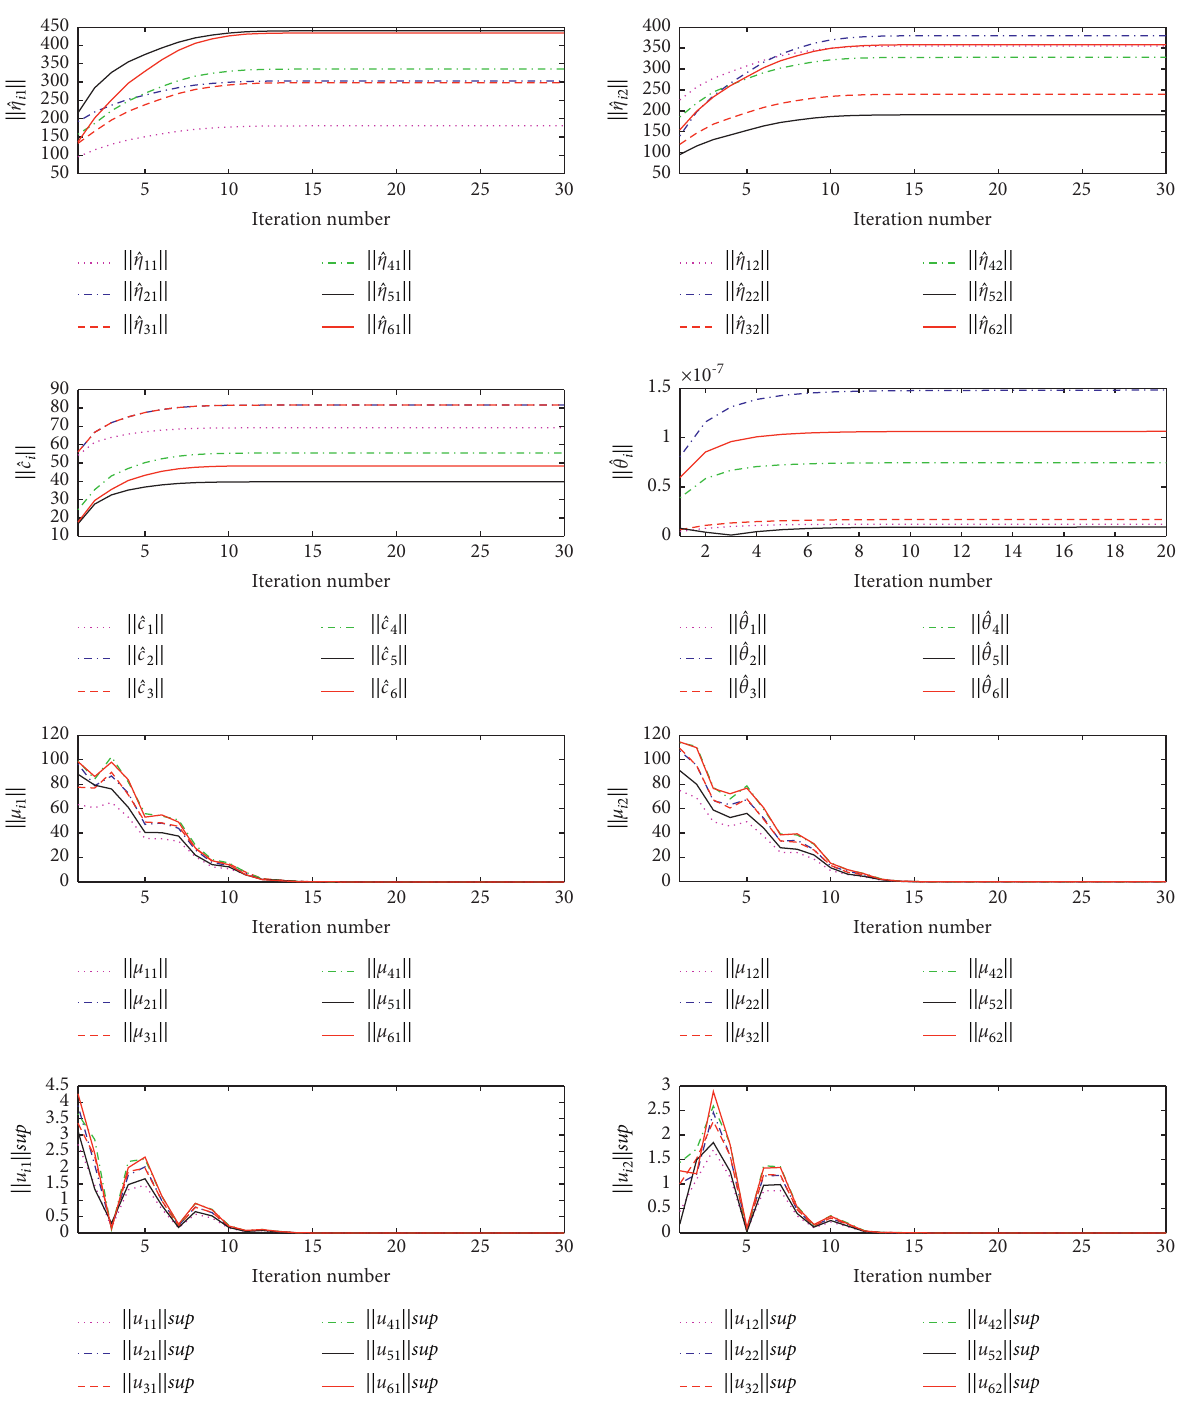
Figure 4: Responses of six followers for Case